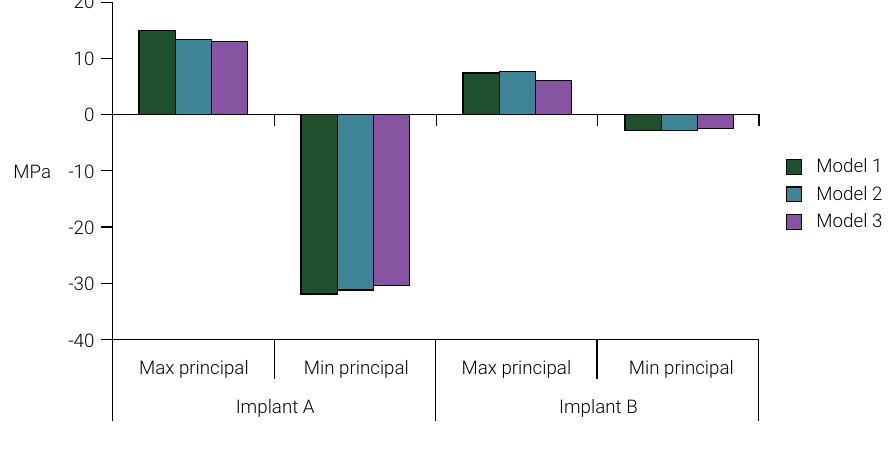
Table 1. Comparison of vertical loading (maximum and minimum principal stress) to implant A and B, on the three full-arch prosthesis evaluated.